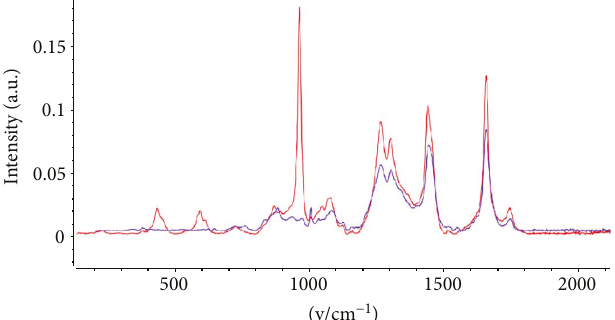
Figure 9: Raman spectra of salmon muscle deposits adhered to the food container walls (blue) and fresh salmon muscle